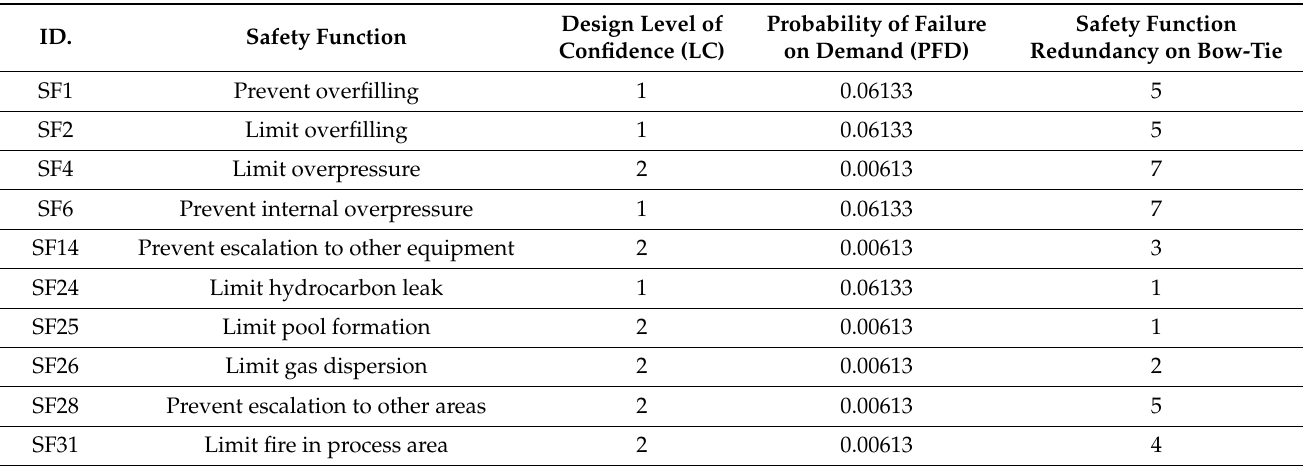
Table 6. Relevant Safety Functions for sensitivity analysis.